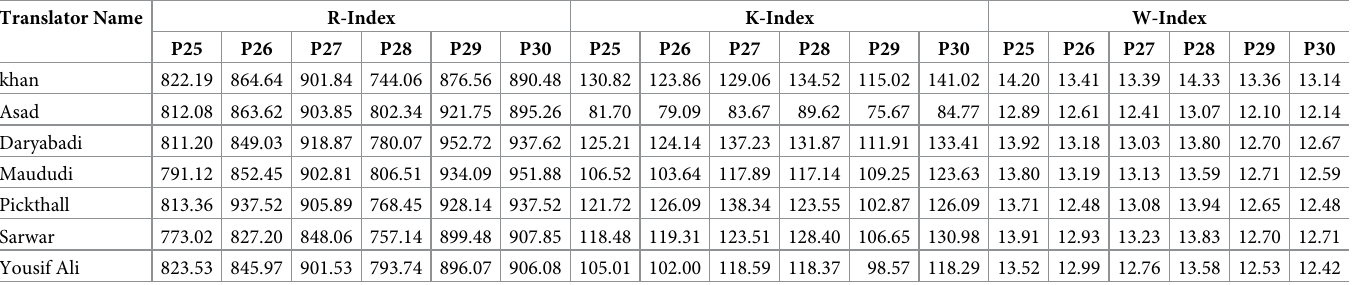
Table 4. Vocabulary richness